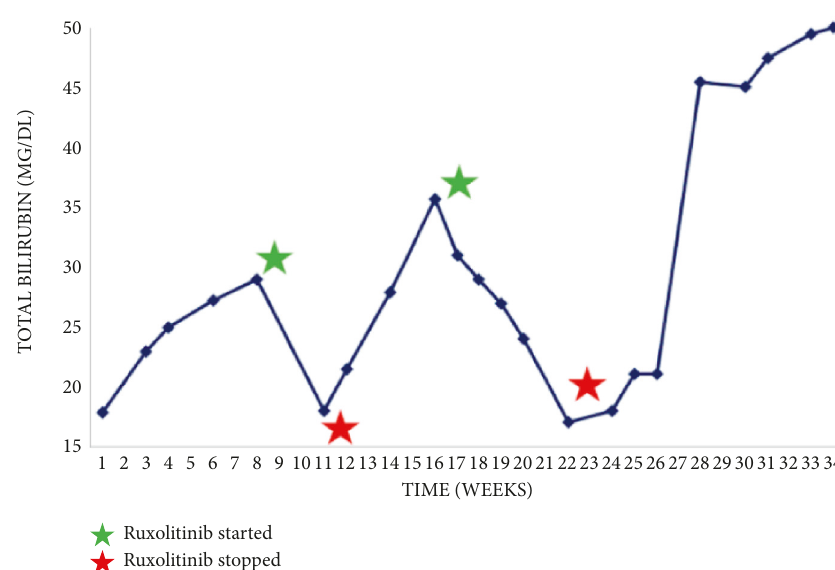
Figure 4: Total bilirubin trends with relation to initiation and discontinuation of